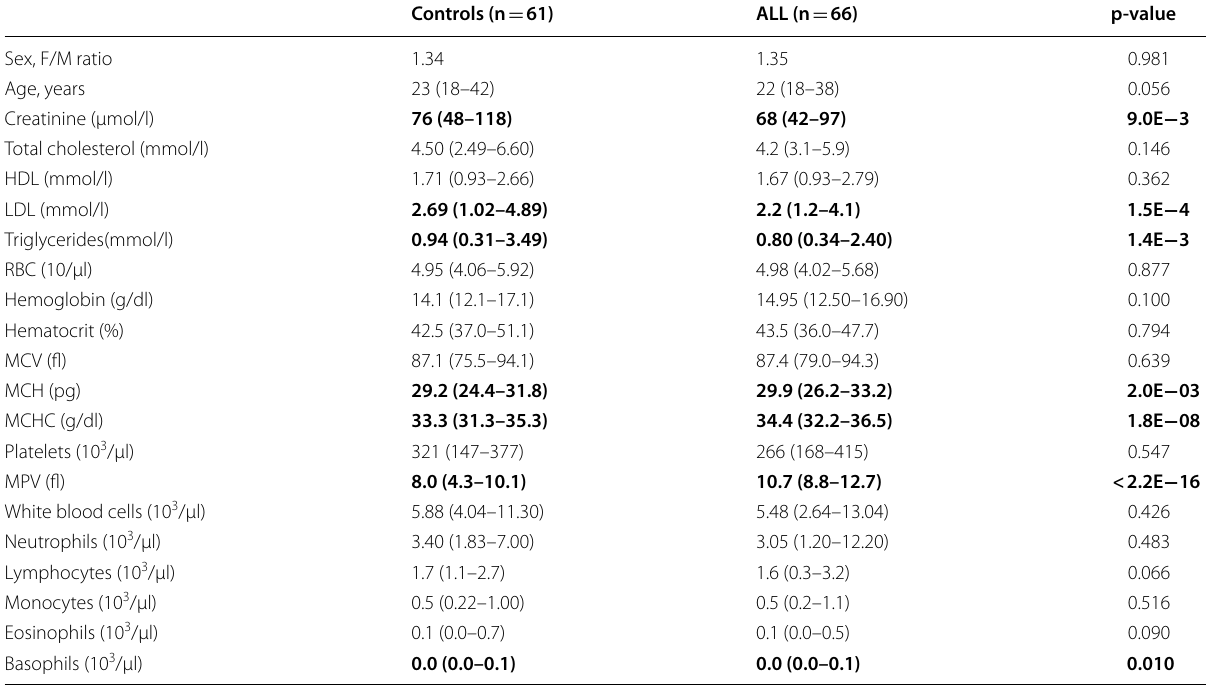
The median (range) values are reported; the p‑value corresponds to the Fisher’s exact test or Wilcoxon signed‑rank test for equality of location parameters in the two groups. P ‑values marked with bold indicate statistically significant ( p ‑value < 0.05) differences between the